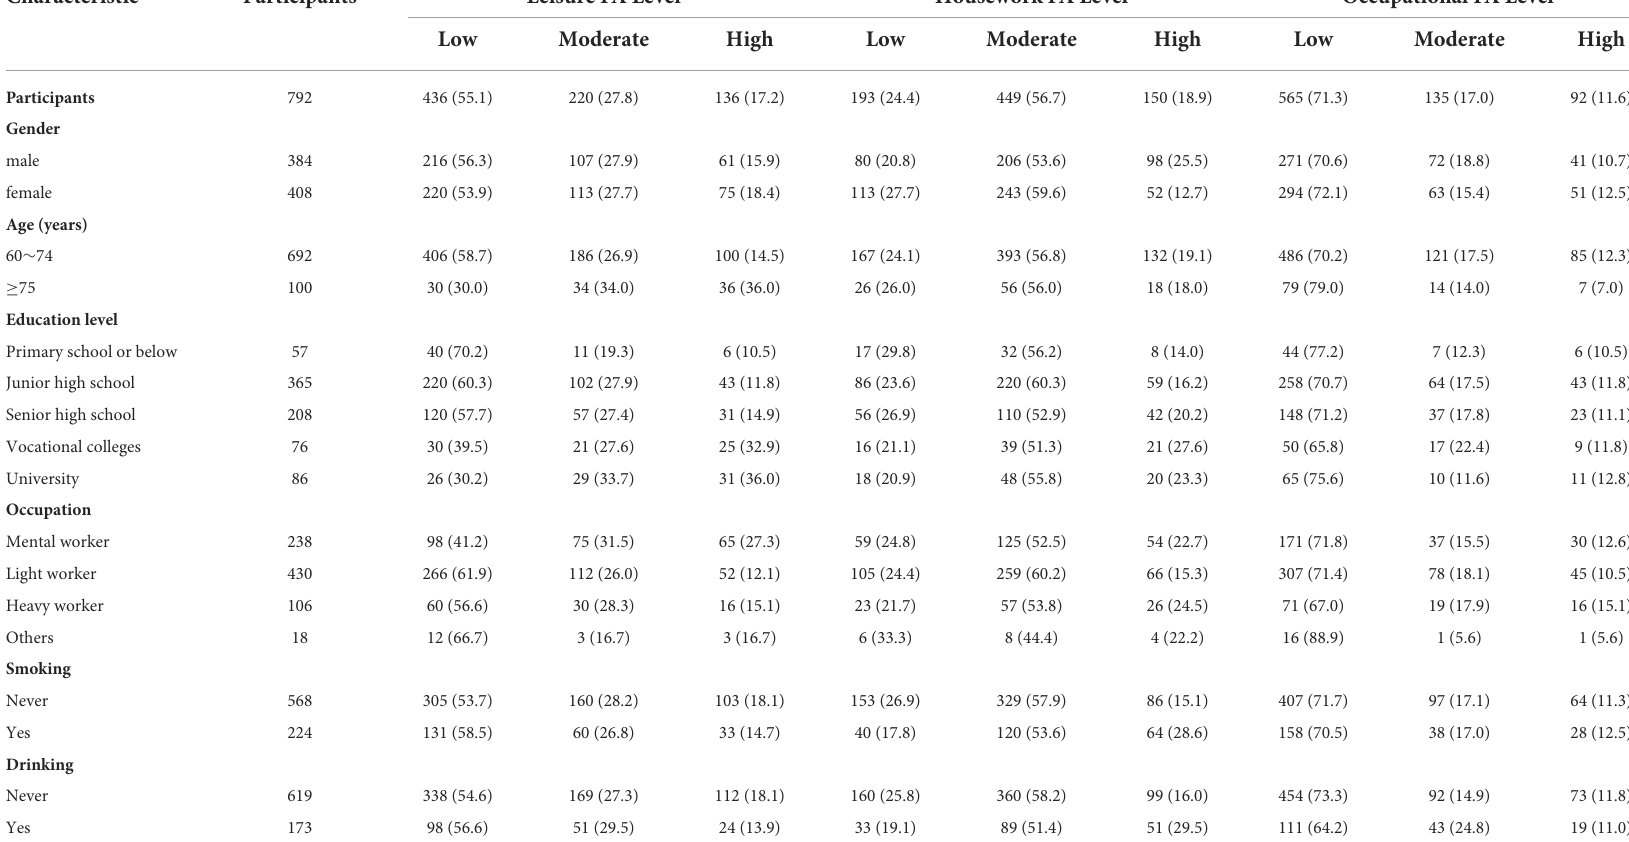
TABLE 1 Descriptive characteristics and physical activity ( n =